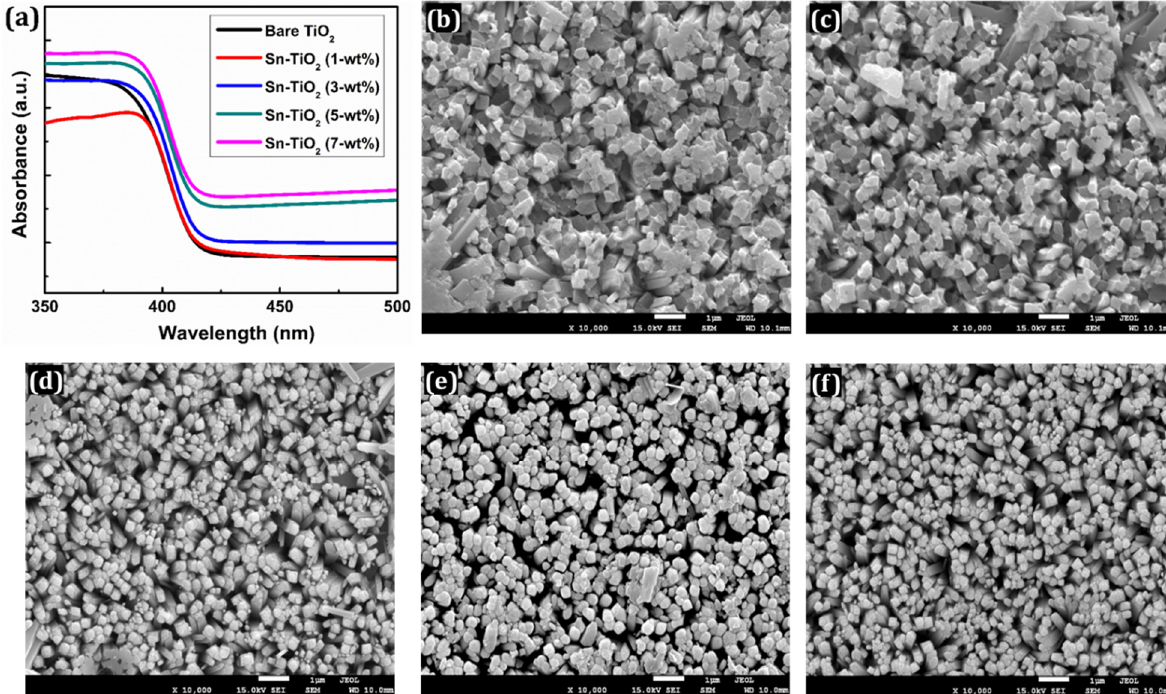
Figure 2. ( a ) UV-visible absorption spectra of bare TiO 2 , 1-wt %, 3-wt %, 5-wt %, and 7-wt % Sn-TiO 2 thin films. FE-SEM images of ( b ) bare TiO 2 ( c ) 1-wt %, ( d ) 3-wt %, ( e ) 5-wt %, and ( f ) 7-wt % Sn-TiO 2 thin films.